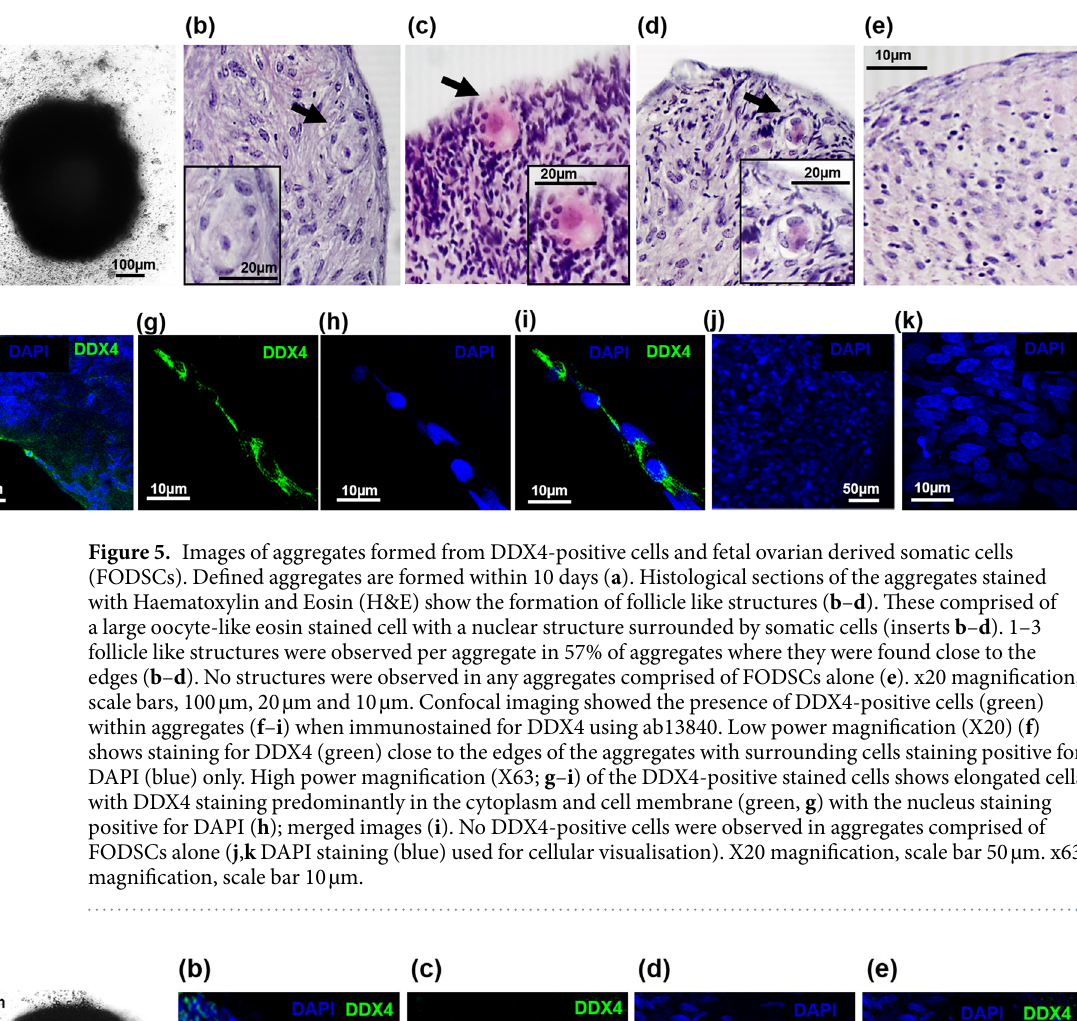
epitope of the C-terminus of DDX4. Similar sized cells were also identified in lineage tracing experiments as contributing to postnatal oogenesis 33 . The DDX4-positive cells represent a heterogeneous population and we have identified a sub-population expressing DDX4 transcripts that lack the 3 ′ PCR priming sites, which also uniquely expressed DAZL . It is suggested therefore, that the DAZL expressing cells contain a splice variant of DDX4 . DAZL is a major regulator of germ cell differentiation 34–36 and is essential for progression into meiosis 37 , thus these cells may represent a more differentiated population of cells. This finding should enable the identification of a progen- itor population of OSCs and characterisation of their differentiation potential.